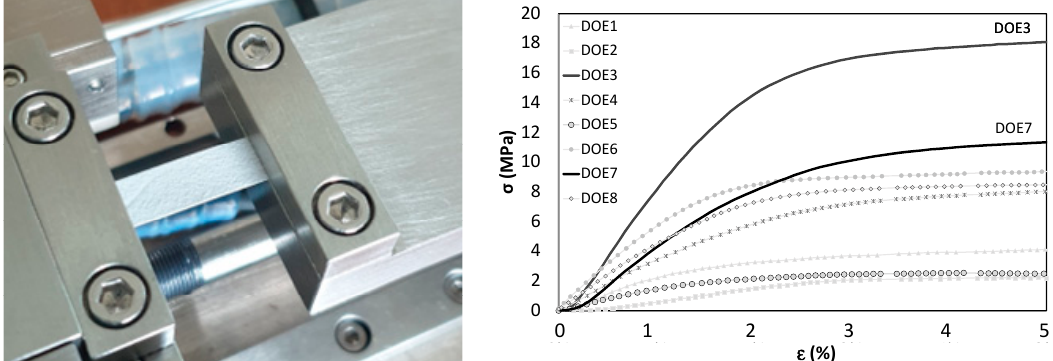
Figure 1. Mechanical characterization of electrospun self-standing membranes to determine formulation with best mechanical performance. Right: vice apparatus for microtensile tests (M200, Deben, UK) with 200 N load cell; left: stress vs. strain data for all DOE samples, with solid black lines highlighting DOE3 and DOE7 with highest UTS and chosen for the coating study.